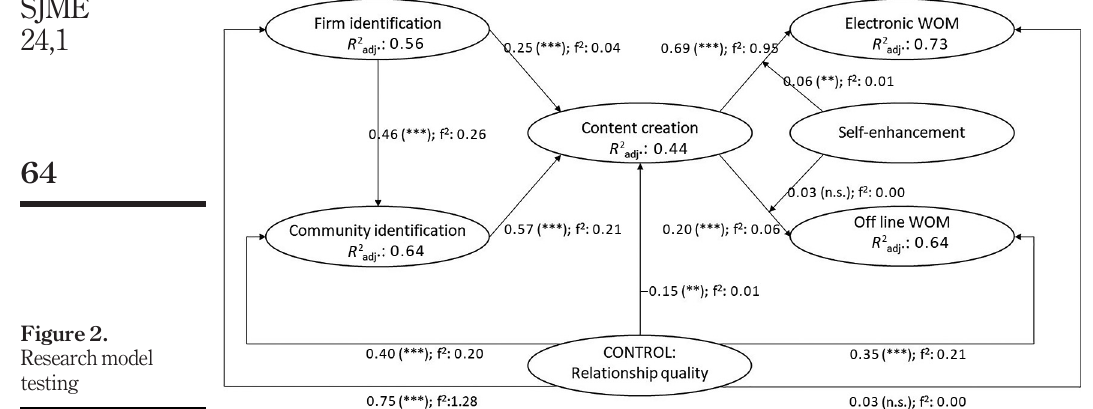
Figure 2. Research